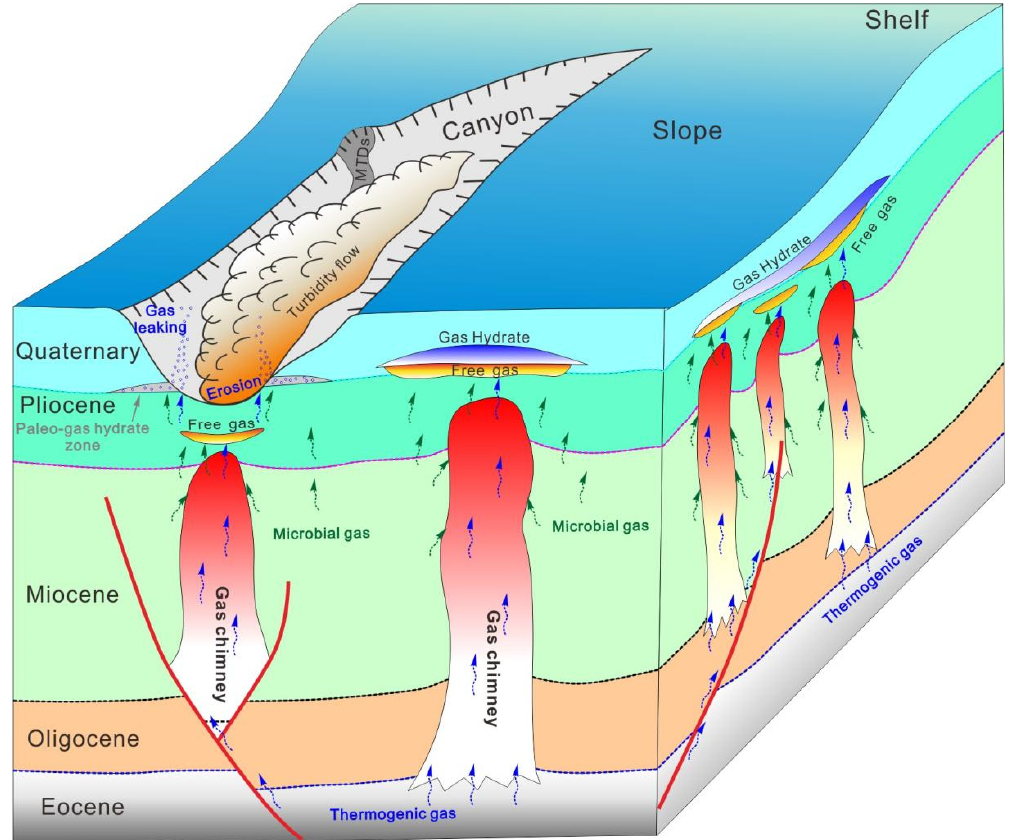
Figure 12. Accumulation model (conceptual model not to scale) of gas hydrate in a canyon developed area, northern South China Sea.